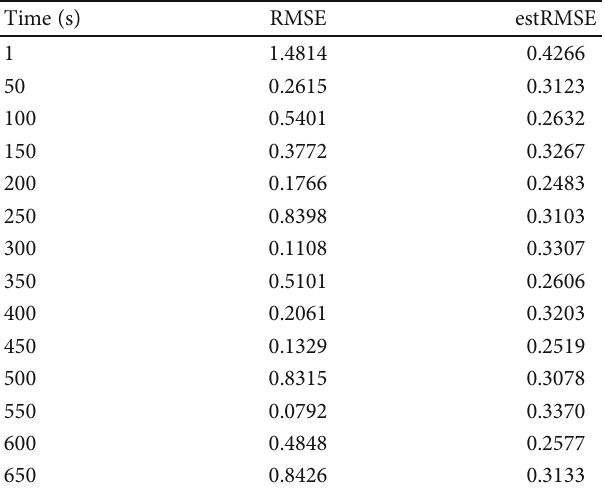
Table 2: Statistics of error